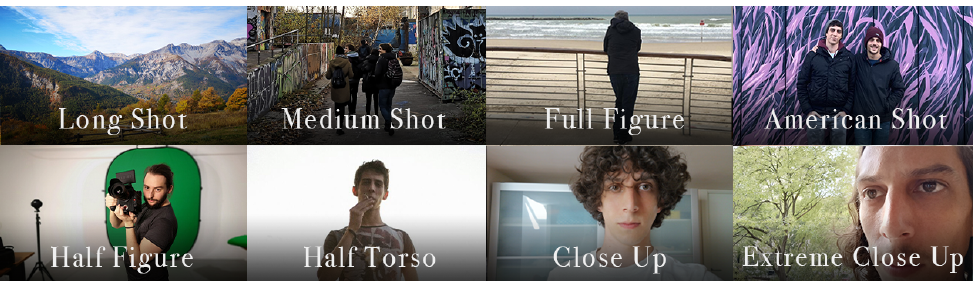
Figure 1. The eight types of shots